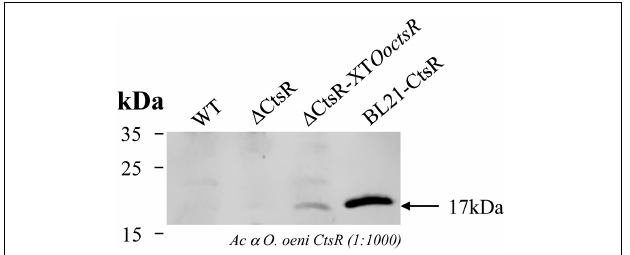
FIGURE 3 | Immunodetection of the O. oeni CtsR protein in B. subtilis . B. subtilis wild-type (WT), ctsR- deficient ( (cid:49) ctsR ) and ctsR -deficient expressing the O. oeni ctsR gene ( (cid:49) ctsR- XT OoctsR ) strains were grown at 28 ◦ C in LB medium and xylose (20 mM) was added at the mid-exponential growth phase (OD 600 = 1.5). Cells were harvested 12 h after adding xylose and total cellular proteins were extracted and analyzed by Western blot using polyclonal antibodies directed against CtsR from O. oeni and anti-rabbit antibodies conjugated with IRDye 680LT fluorophore (LiCor R (cid:13) ) as secondary antibody. Total protein extract from E. coli BL21 carrying pET ctsR plasmid (BL21-CtsR) strain was used as a positive control.